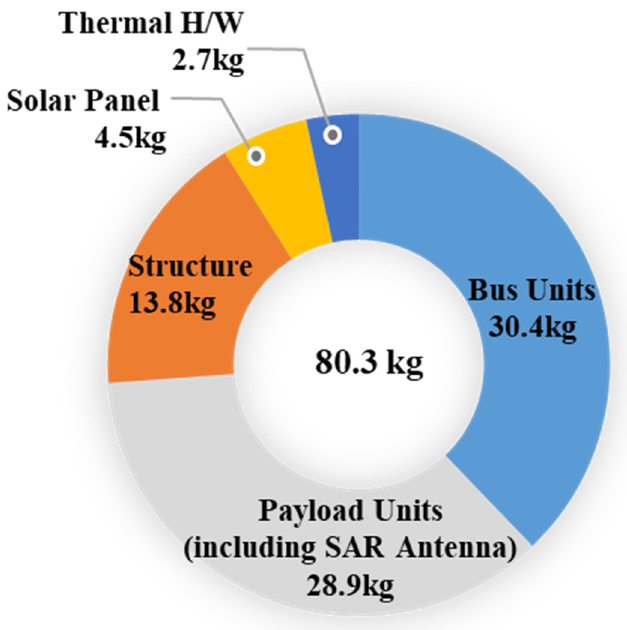
Figure 2. Mass ratio of the S-STEP system.